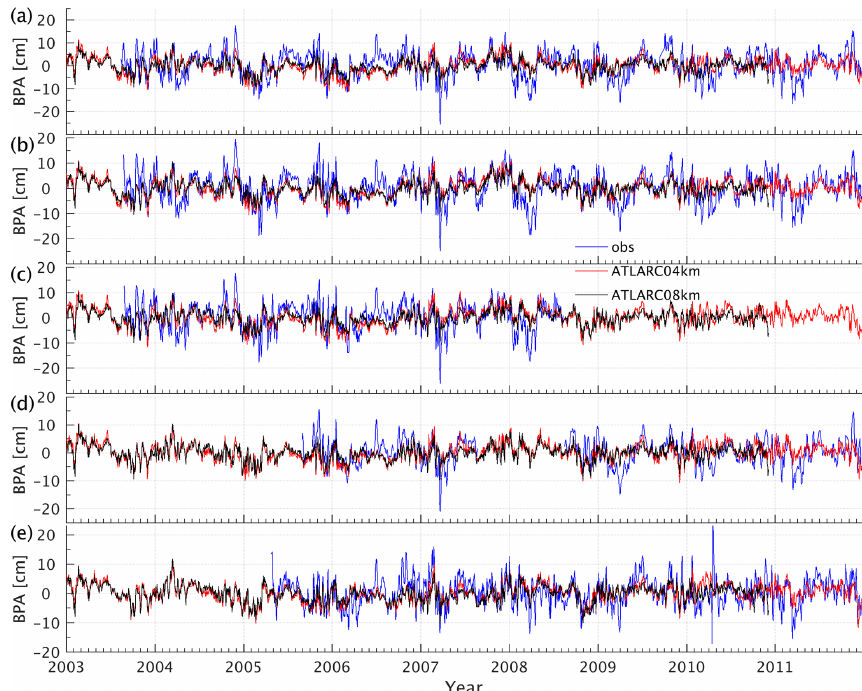
Figure 3. Time series of bottom pressure anomalies in ATLARC08km, ATLARC04km, and in situ observations. Observations are derived from (a) mooring A, (b) mooring B, (c) mooring C, and (d) mooring D of BGEP. Panel (e) is from the North Pole Environmental Observatory (NEPO) moorings. Mooring locations are marked in Fig.